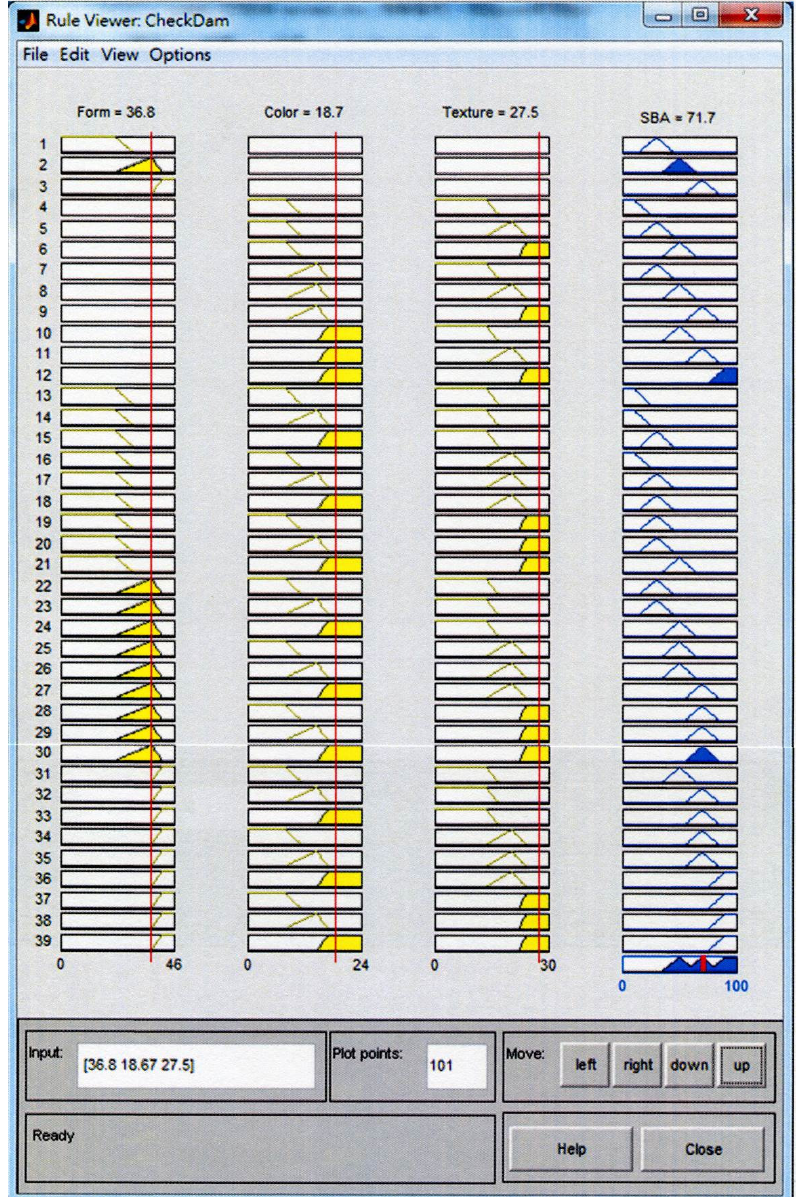
Figure 7. Result of fuzzy logical system.